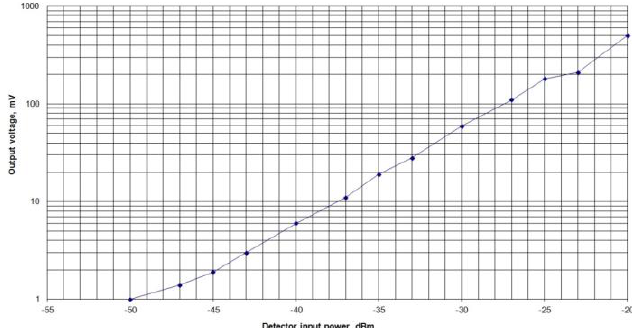
Fig. 2. HSMS-2862 Schottky Diode Detector